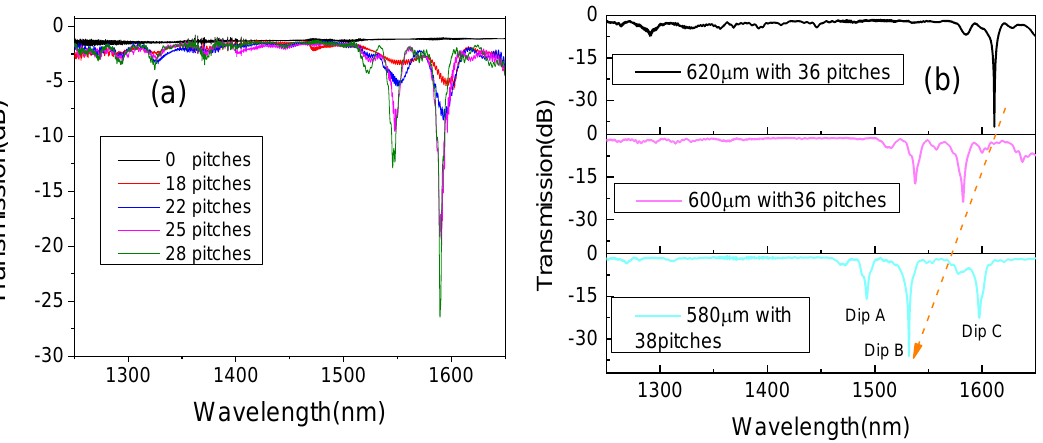
Figure 2. ( a ) Transmission intensities of the LPFG as it forms (for an increasing number of pitches), and ( b ) the intensities of LPFGs with three different pitches.